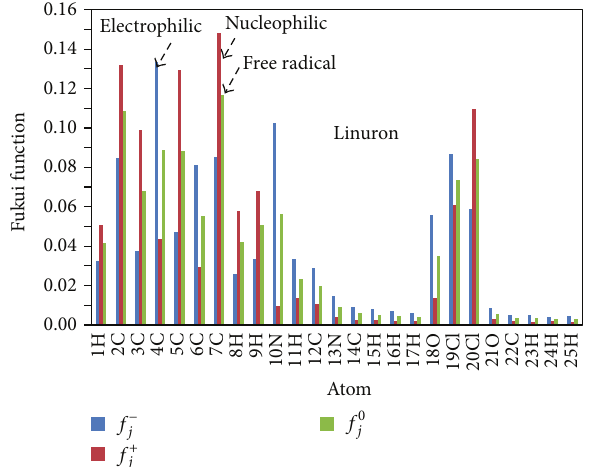
Figure 8: Values of the Fukui function for linuron considering Hirshfeld charges according to (7).